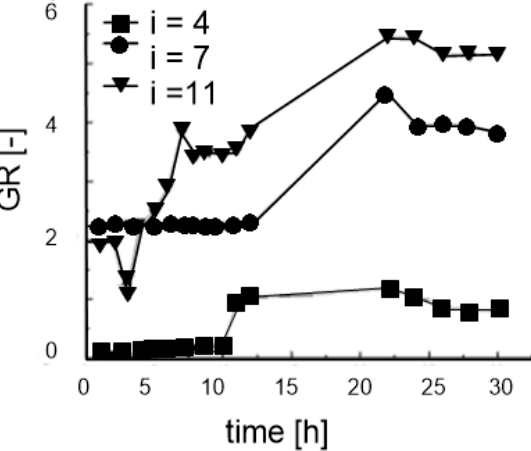
Figure 11. Gradient ratio versus time and hydraulic gradient (adapted from [78]).